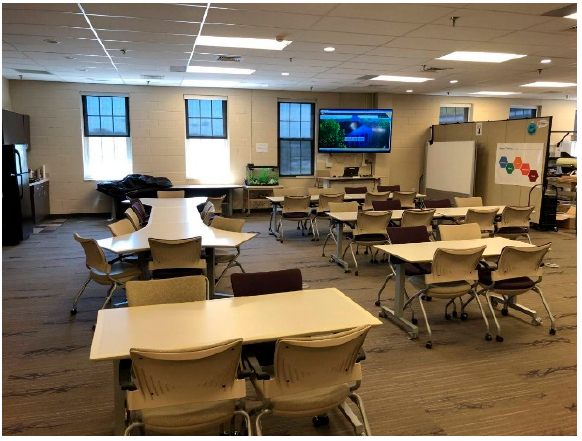
Figure 1. iMakerSpace Studio for team meetings and discussions, lectures, and events.